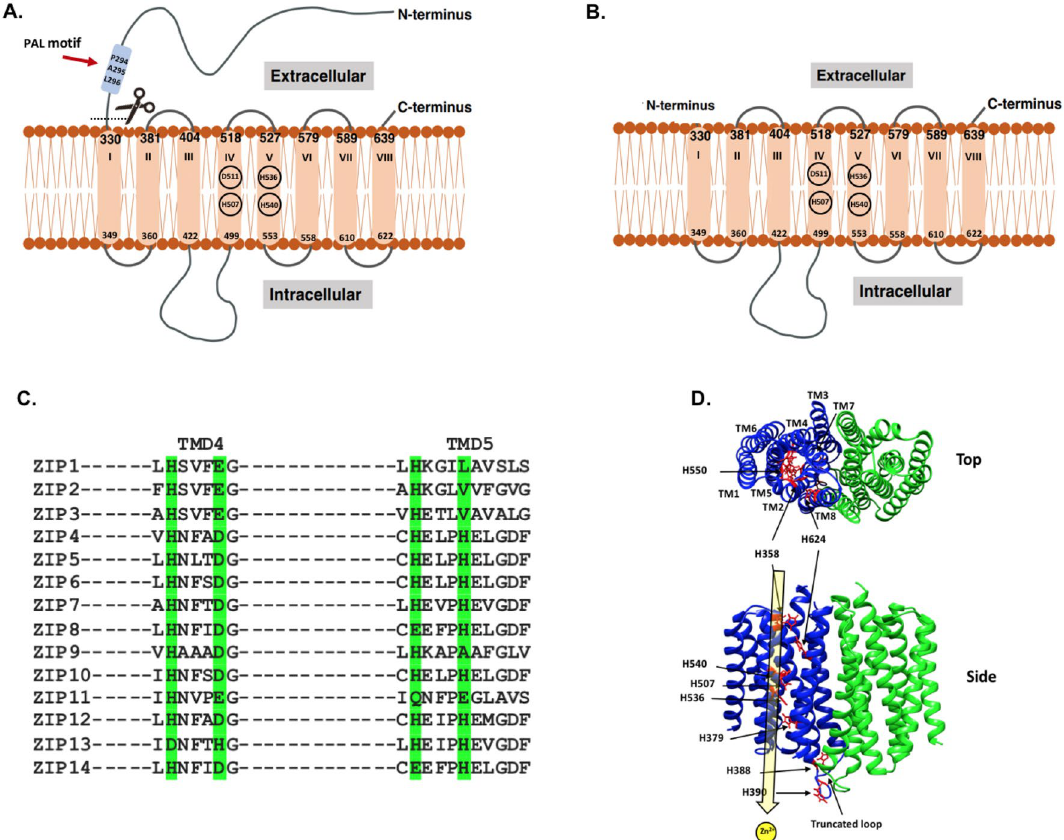
Figure 1. The topology of ZIP4 ( A ) and truncated ZIP4 ( B ), the sequence alignment of ZIP transmembrane domain (TMD) 4 & 5 ( C ), and the computational study of ZIP4 transmembrane ( D ). ( A ) The full-length ZIP4 has eight transmembrane (TM1 to TM8) segments crossing the plasma membrane with a large N-terminus (1–327 residues) and C-terminus facing the extracellular environment. ( B ) The N-terminus (1–327 residues) has been removed from the full-length ZIP4 at the spot indicated by figure ( A ), the membrane domain ( B ) known as the truncated ZIP4. ( C ) Sequence alignment of human ZIP proteins TMD4 and TMD5. Conserved